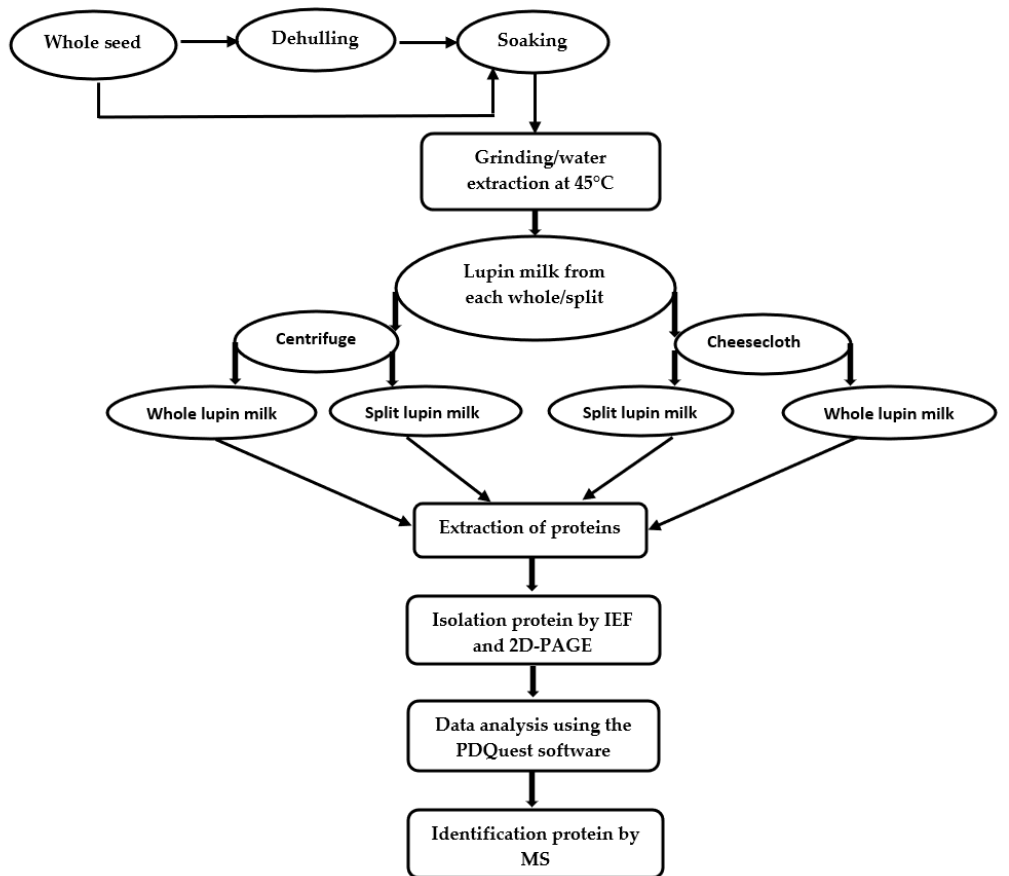
Table S1. Molecules 2020 , 25 , x FOR PEER REVIEW